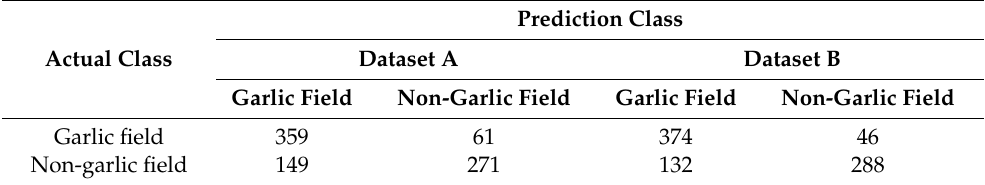
Table 13. Confusion matrix of classification model generated using the k -NN method.